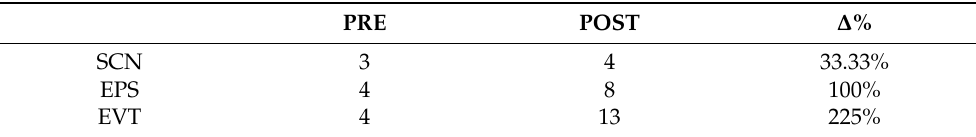
Table 7. Macrostructure of Narrative